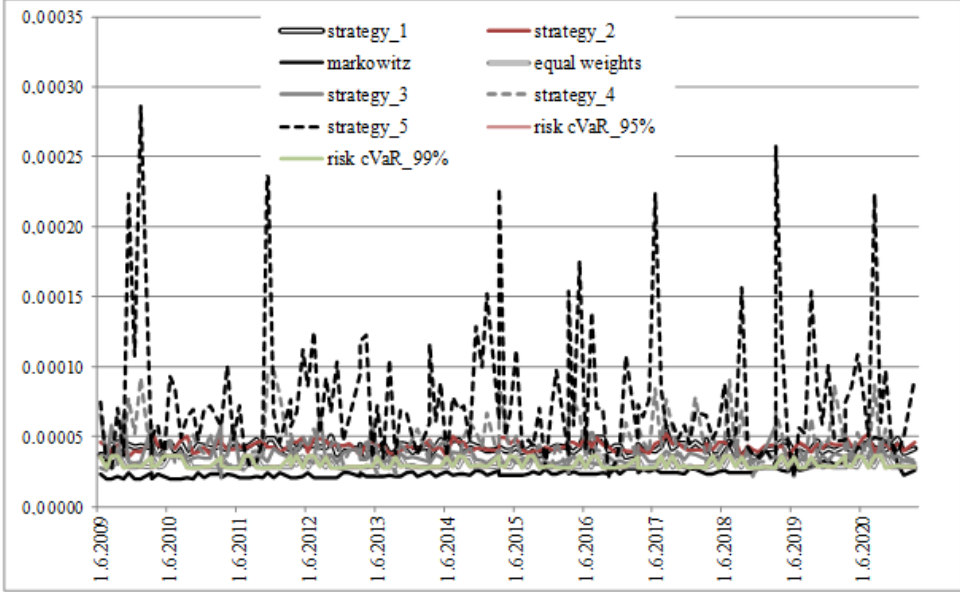
Figure 4. Portfolio risk over time.